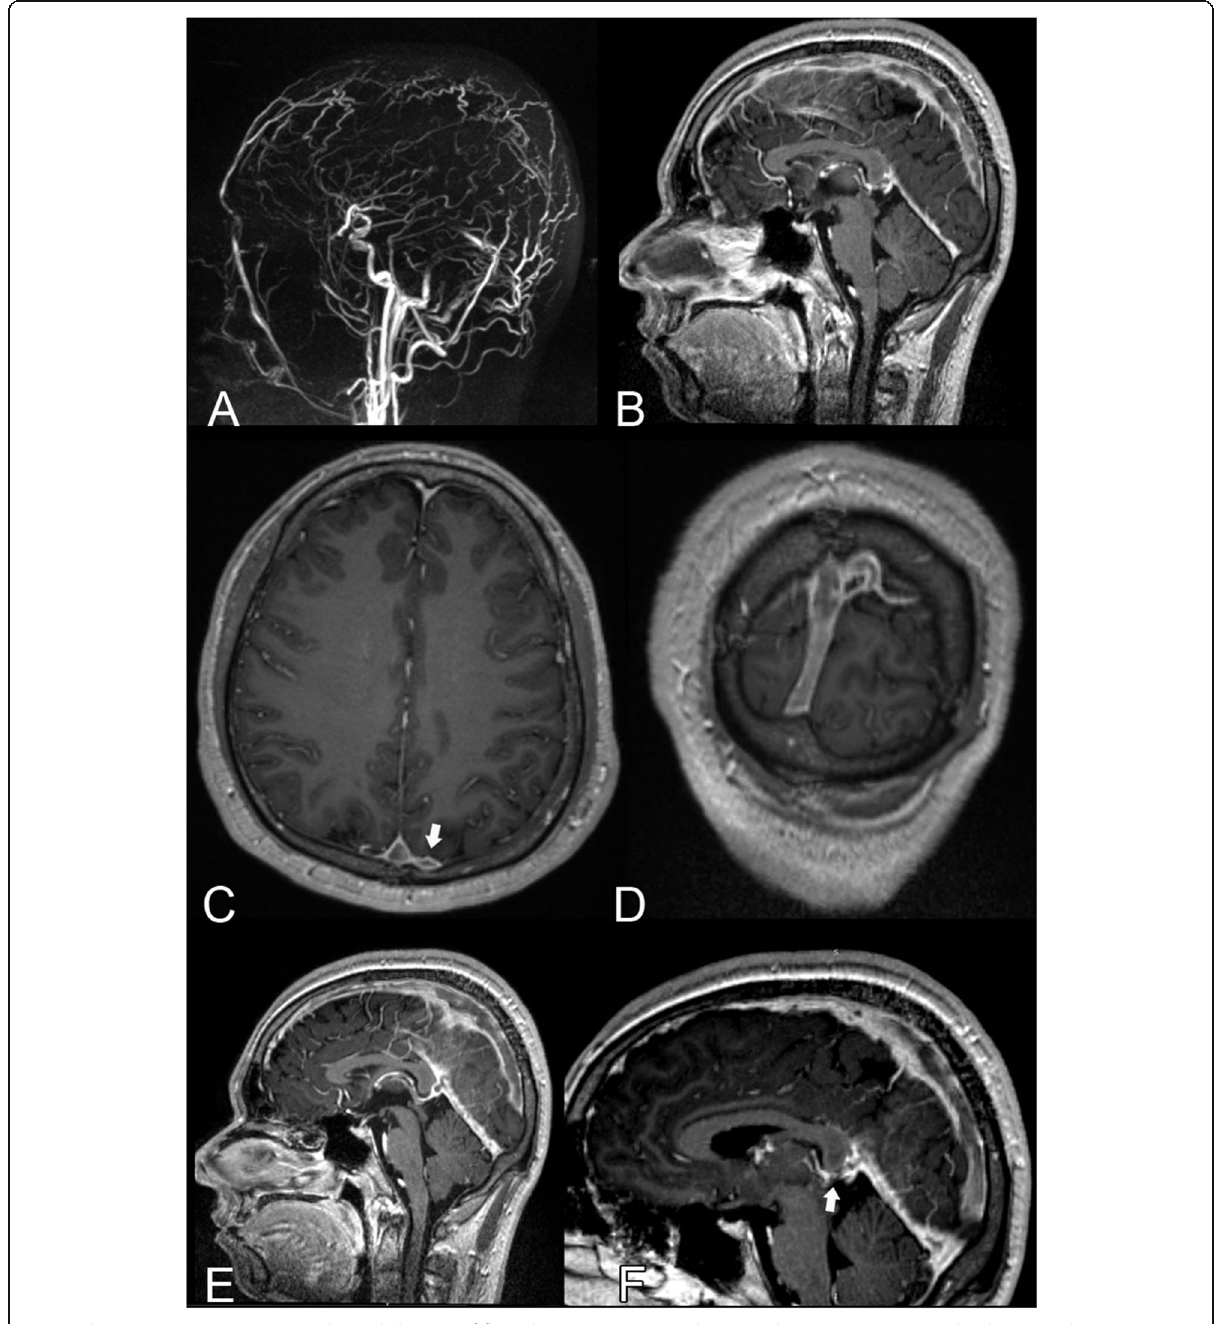
Fig. 2 Phase contrast MR venogram showed absence of flow along superior sagittal sinus, right transverse sinus and right sigmoid sinus ( a ). Contrast-enhanced MRI confirmed extensive cerebral venous sinus thrombosis ( b ). Associated thrombosis of the superficial cortical vein (arrow) seen in axial ( c ) and oblique-sagittal ( d ) post contrast T1 MPRAGE. Sagittal T1C+ images revealed partial thrombus in the vein of Galen ( e ) extending into the proximal part of the internal cerebral vein (arrow, f